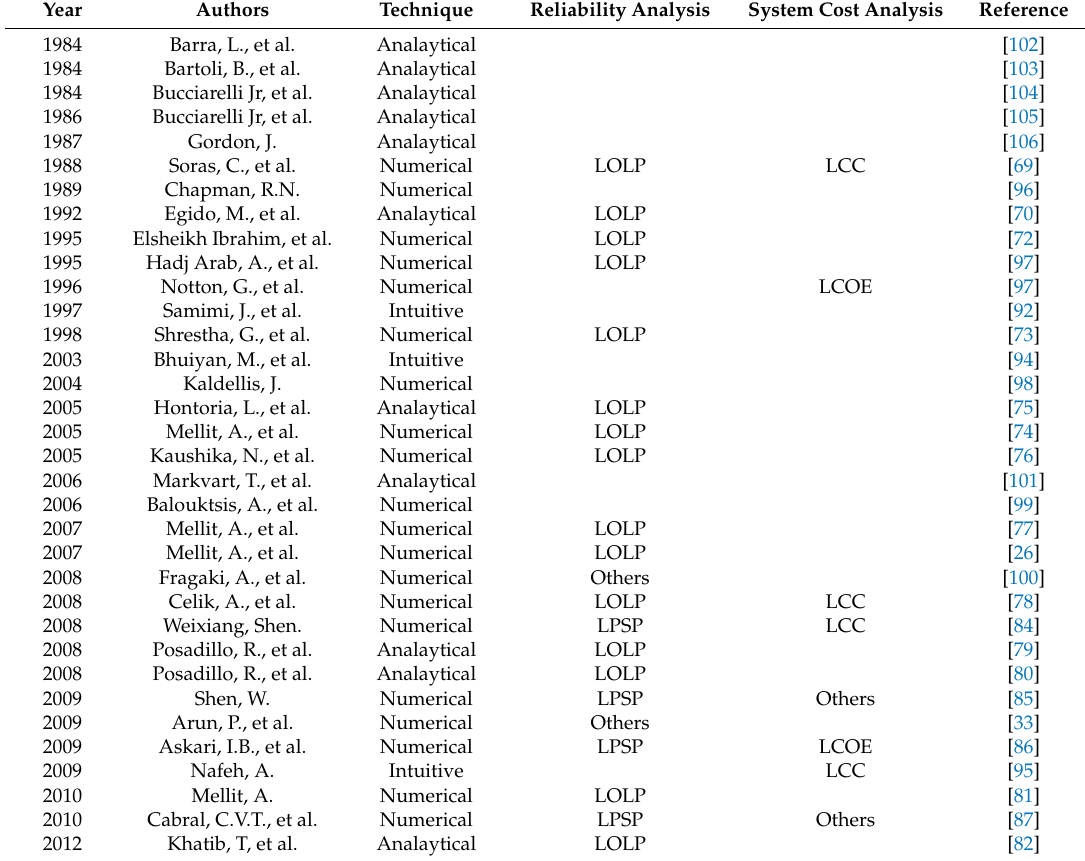
Table 2. Summary of SAPV optimal sizing